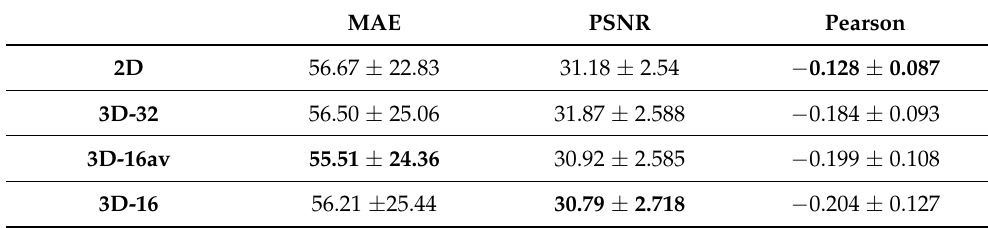
Table 23. Pelvis dataset Fat with Atrous-net. Mean Absolute Error, PSNR and Pearson coefficient from Atrous-net using different convolutions and reconstructions in the Pelvis data set within the